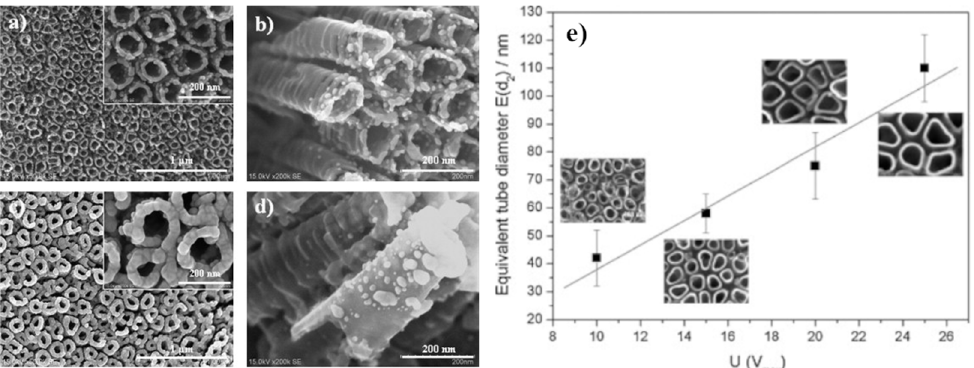
Figure 3. ( a – d ) SEM images of a layer of TiO 2 nanotubes formed by the anodization of Ti foil in a glycol fluoride solution at 25 V covered by various amounts of Ag: ( a , b ) 0.01 mg · cm − 2 , ( c , d ) 0.06 mg · cm − 2 . ( e ) The diagram presenting the dependence between applied anodic voltage and the diameter of formed nanotubes. Reprinted with permission from [19]. Copyright 2010 Elsevier.